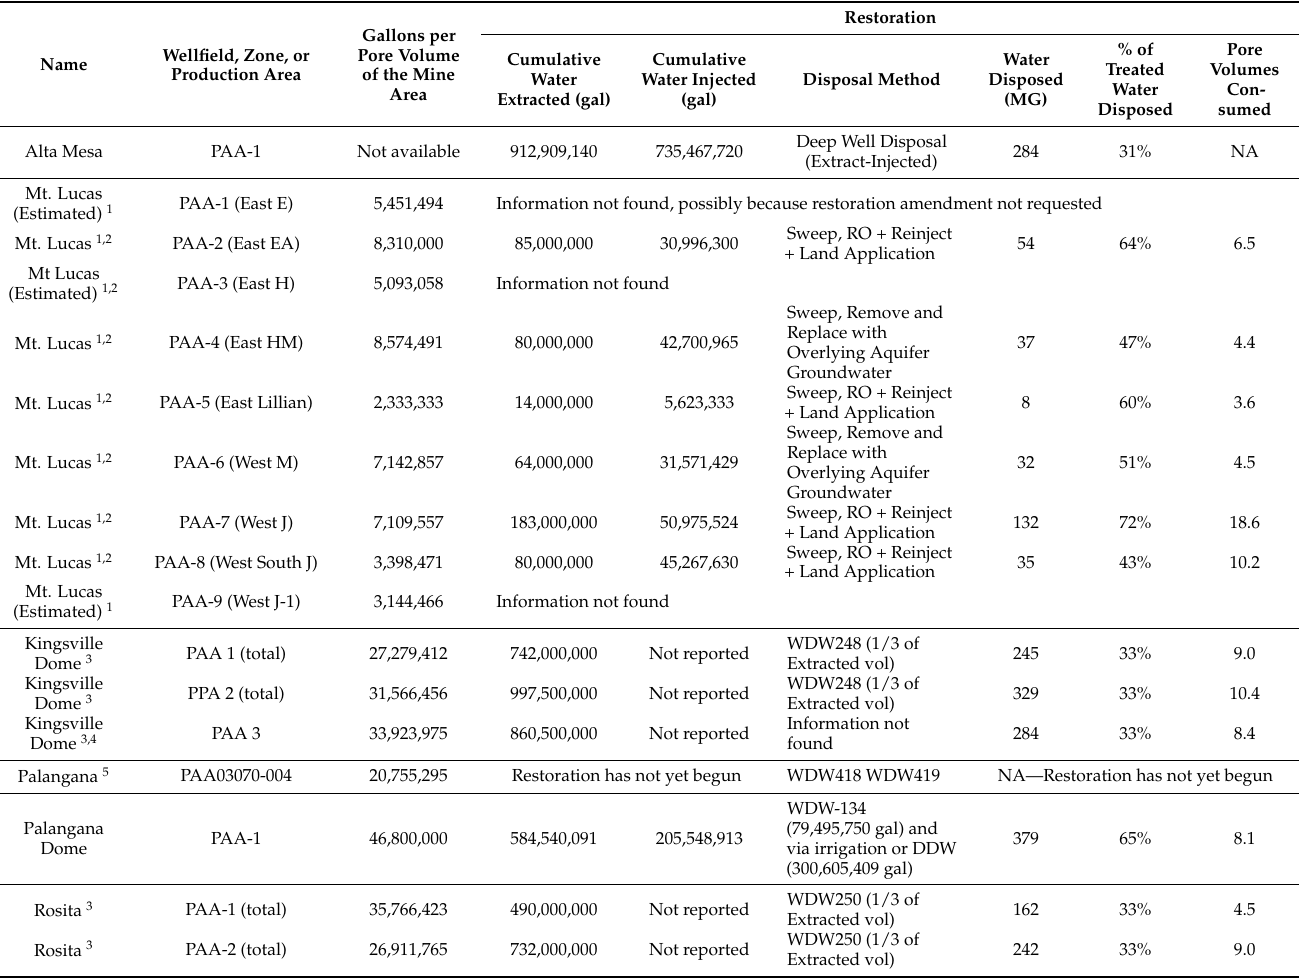
Table A6. Minimum amounts of water removed and disposed during